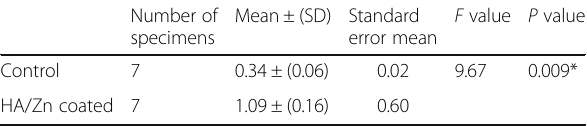
Table 1 The Student t test of the control and coated specimen roughness Ra ( μ